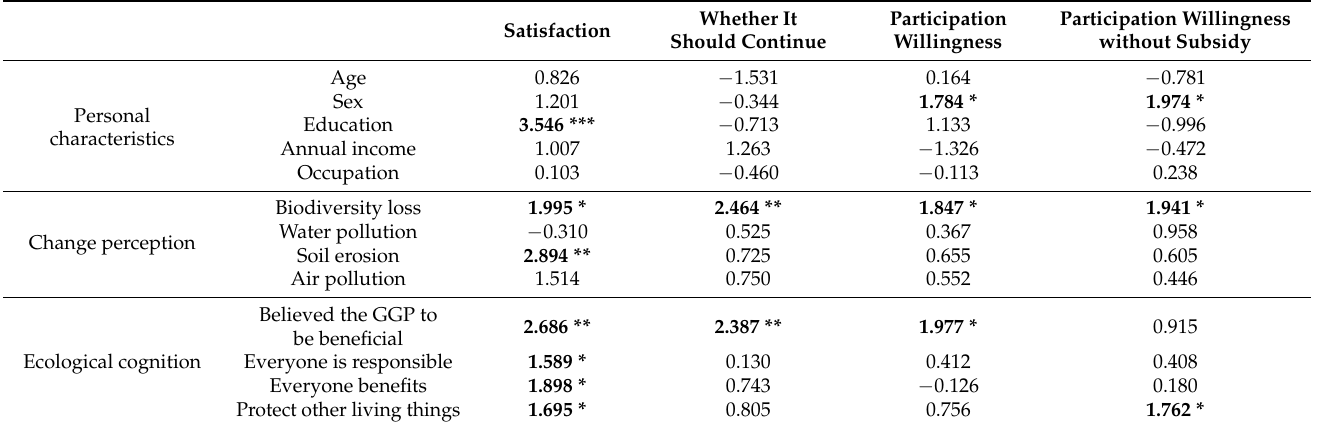
Table 4. The relationship between farmers’ satisfaction, attitude, willingness to participate, and personal characteristics, change perception, and ecological